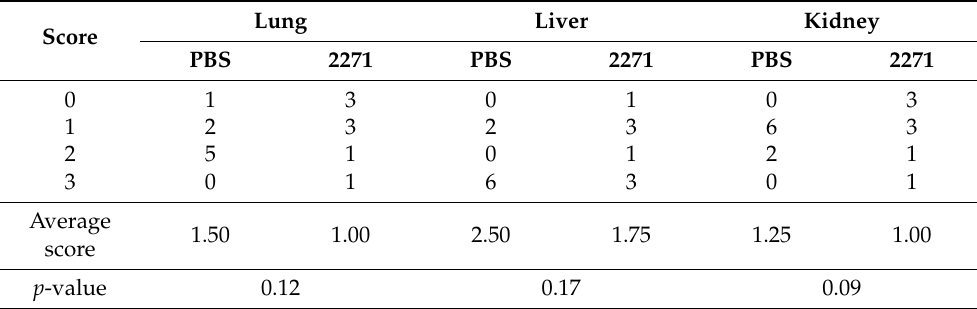
Table 2. The prophylactic efficacy of the rhKU_Sej_LRR_2271 protein was evaluated based on histopathological lesion scores in various organs from challenged animals. Tissues from eight ham- sters in each group were individually harvested and fixed. A board-certified veterinary pathologist graded the lesions in the lung, liver, and kidney of hamsters from control (PBS) and immunized (2271) groups on a scale of severity. Lung tissues were graded for severity of hemorrhage (0 = normal, 1 = focal, 2 = multifocal, 3 = extensive areas of hemorrhage). Liver tissues were graded for the number of inflammatory foci (0 = normal, 1 = 1–3, 2 = 4–7, 3 = >7). Kidney tissues were graded for severity of renal lesions (0 = normal, 1 = mild, 2 = moderate, 3 = severe tubulointerstitial nephritis). The difference between results from each tissue for the control and immunized hamsters is indicated by p